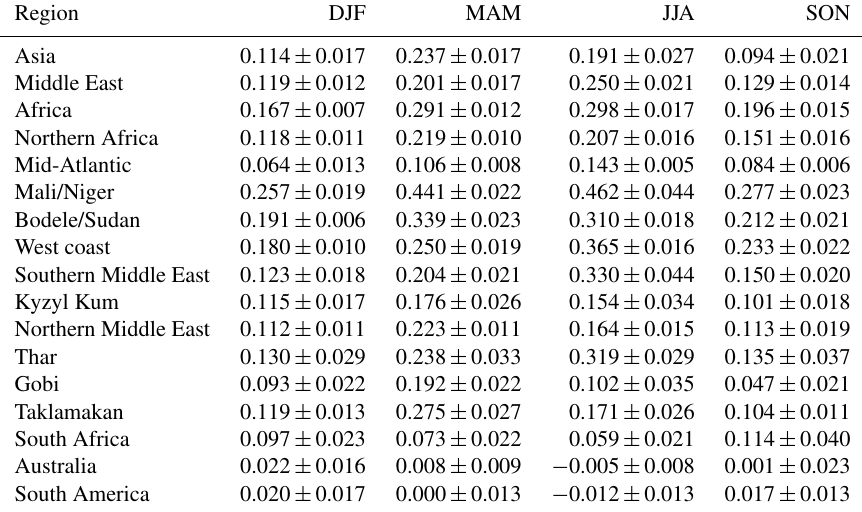
Table 3. Observational estimates of the seasonal dust AOD in each region of Fig. 1, averaged over 2004–2008. The first three rows show the seasonal dust AOD for the broad regions (grouped by color in Fig. 1; Africa does not include the Gulf of Guinea